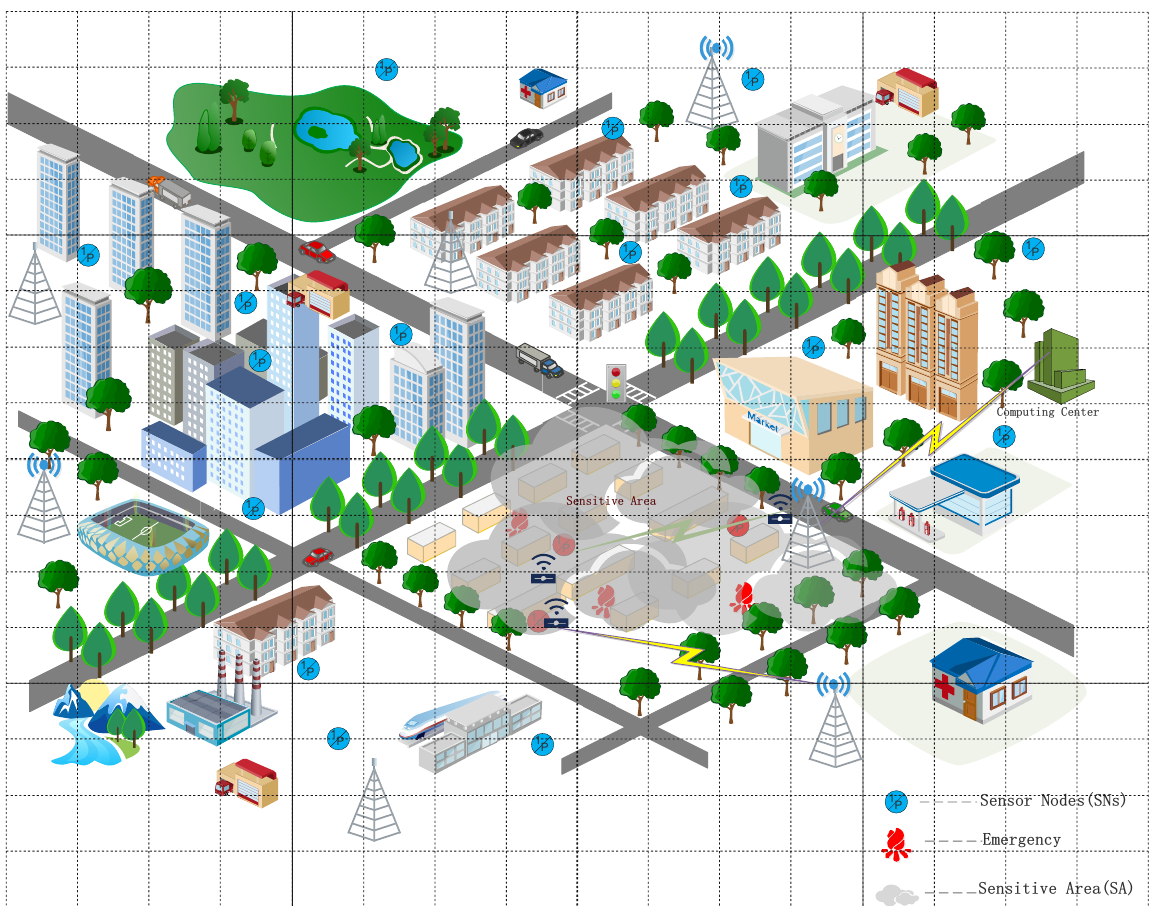
Figure 1. Sensitive area in